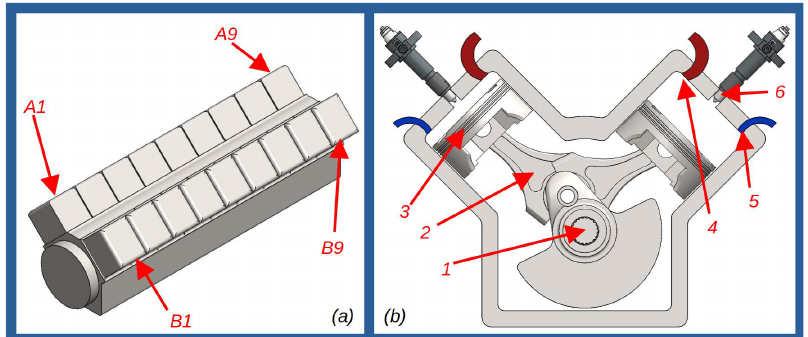
Figure 1. Didactic illustration of the 18V46 engine—( a ) positioning of the cylinders—( b ) parts of the cylinders.